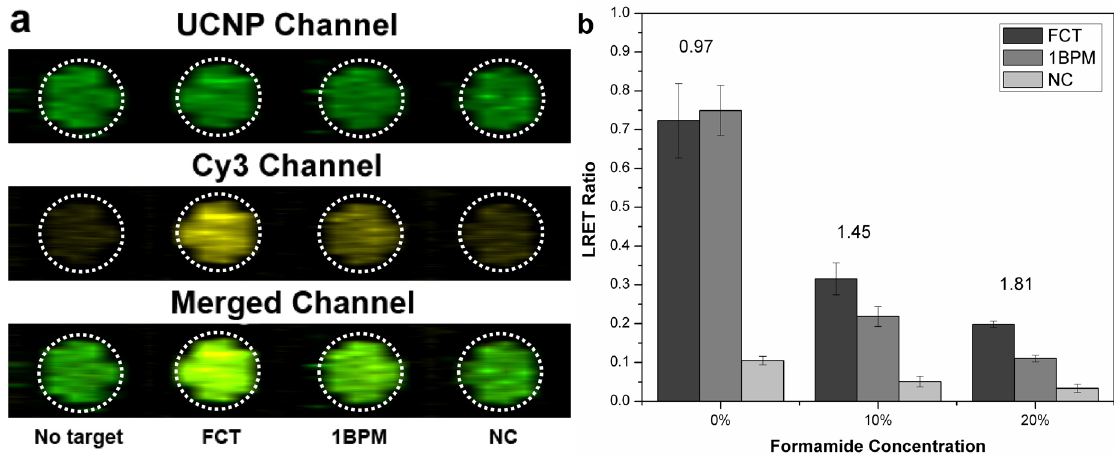
Figure 4. Evaluation of selectivity of the sandwich format hybridization assay for FCT